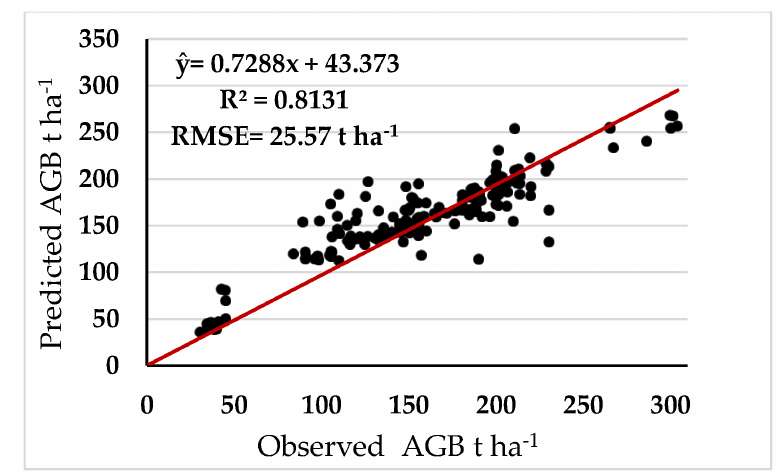
Figure 2. Observed vs. predicted AGB using the RF algorithm based on all predictor variables ( n =